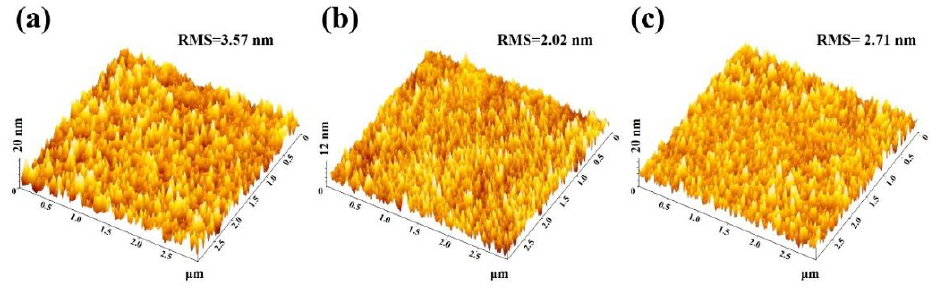
Figure 2. AFM three-dimensional morphology and calculated RMS results of Ni/Ni 3 Al-MoW mul- tilayers with different h : ( a ) 160 nm; ( b ) 40 nm; ( c ) 10 nm. multilayers with different h : ( a ) 160 nm; ( b ) 40 nm; ( c ) 10